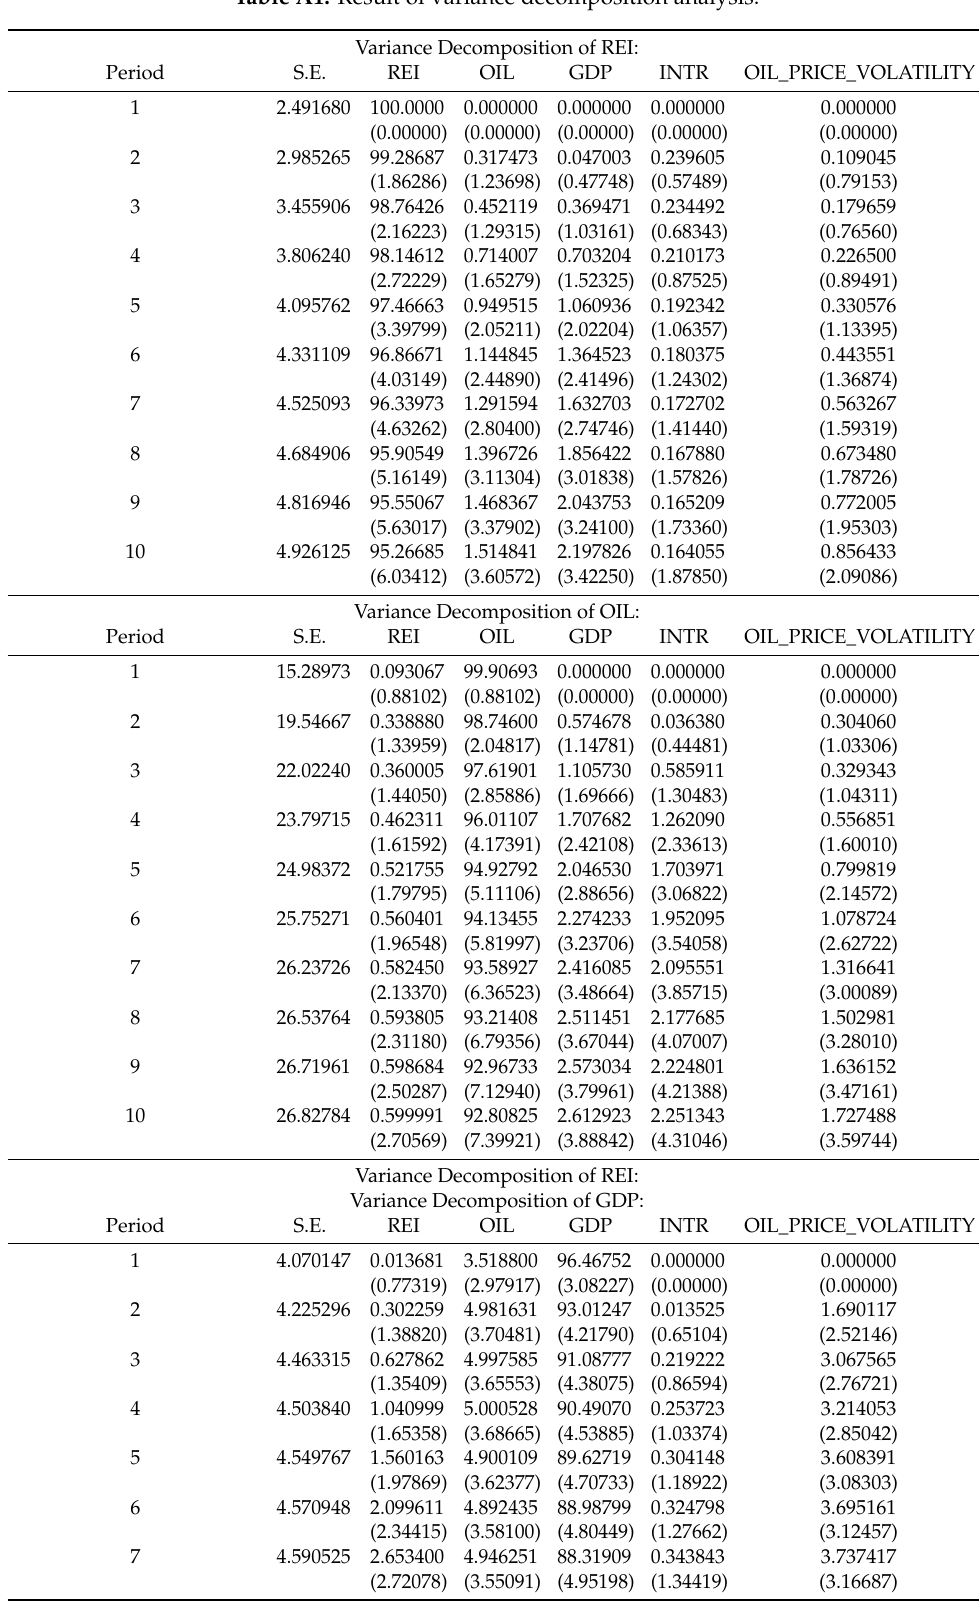
Table A1. Result of variance decomposition